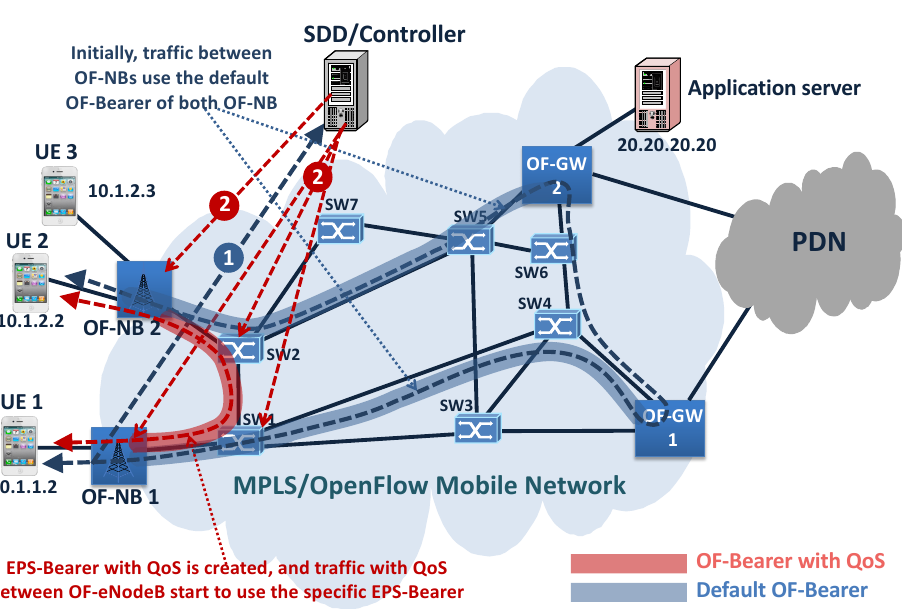
Figure 8. Prototype: Example 2, EPS-Bearer with QoS between